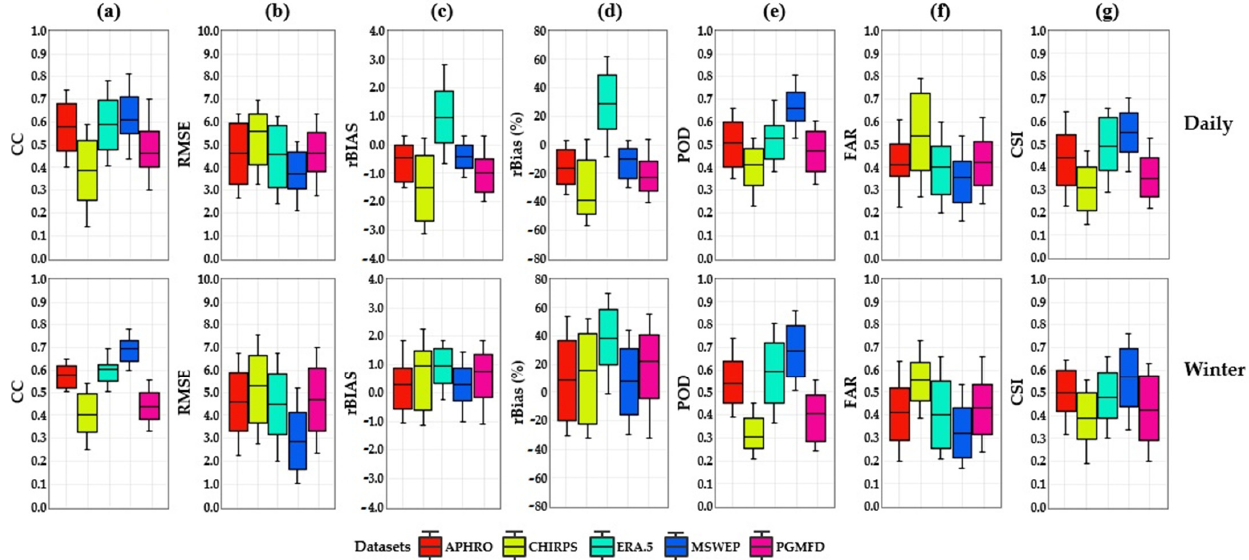
Figure 5. The performance of GPPs in SBs daily and during monsoon season. The lines of each box from bottom to top represent the minimum, first quartile, median, third quartile, and maximum values, respectively. ( a ) Correlation coefficient, ( b ) Root Mean Square Error, ( c ) relative Bias, ( d ) Relative Bias in percentage, ( e ) Probability of Detection, ( f ) False Alarm Ratio, ( g ) Critical Success